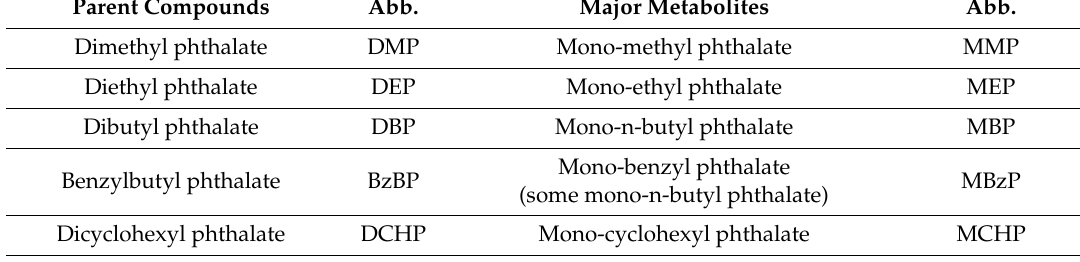
Table 1. Major phthalate diesters and their corresponding metabolites studied in the literature. Parent Compounds Abb. Major Metabolites